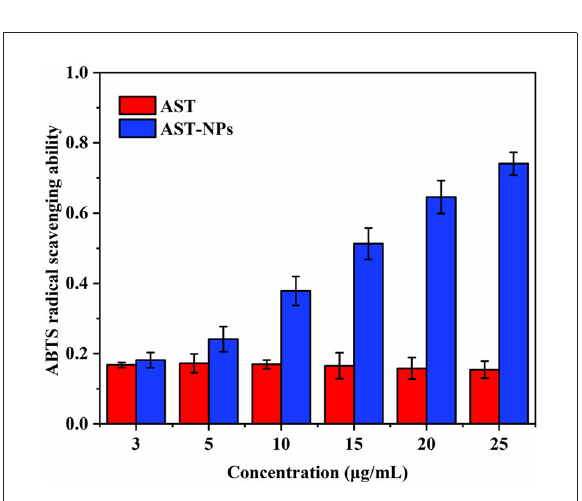
FIGURE8 ABTS radical scavenging ability of free AST and